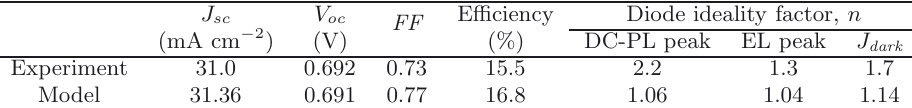
Table 1. Solar cell output parameters and the diode ideality factor of the DC-PL peak tion intensity versus V curve, the EL peak intensity versus V curve and the dark J ( V ) characteristic of the deposited HJ solar cell on n -type wafer, compared to modelling results.